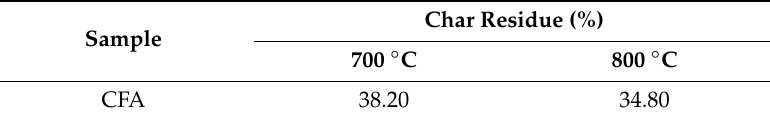
Table 2. Thermal degradation data of CFA.